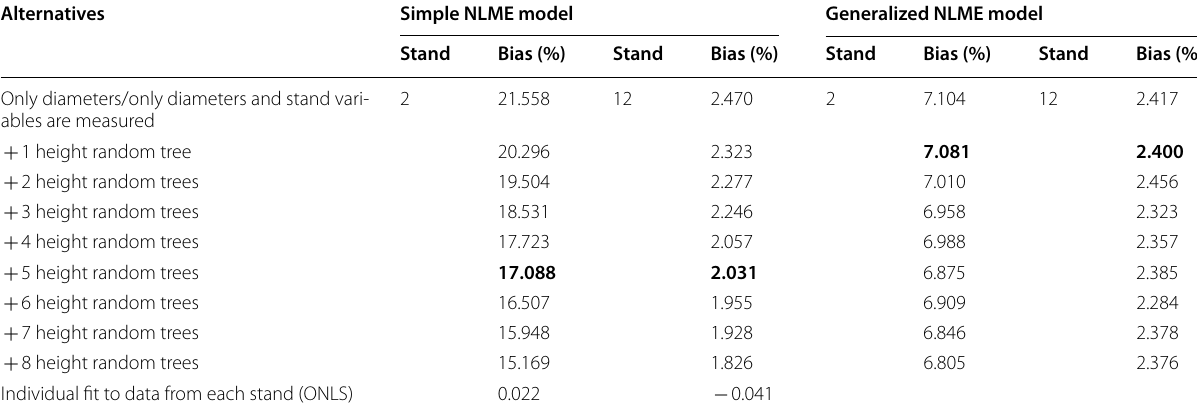
Bold, statistics of selected models